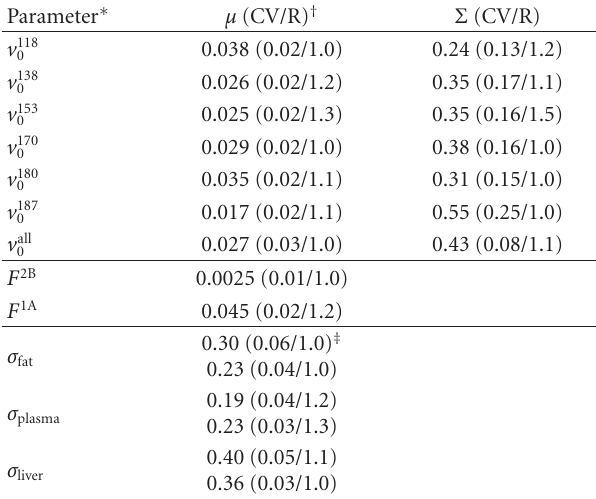
Table 5: Population posterior